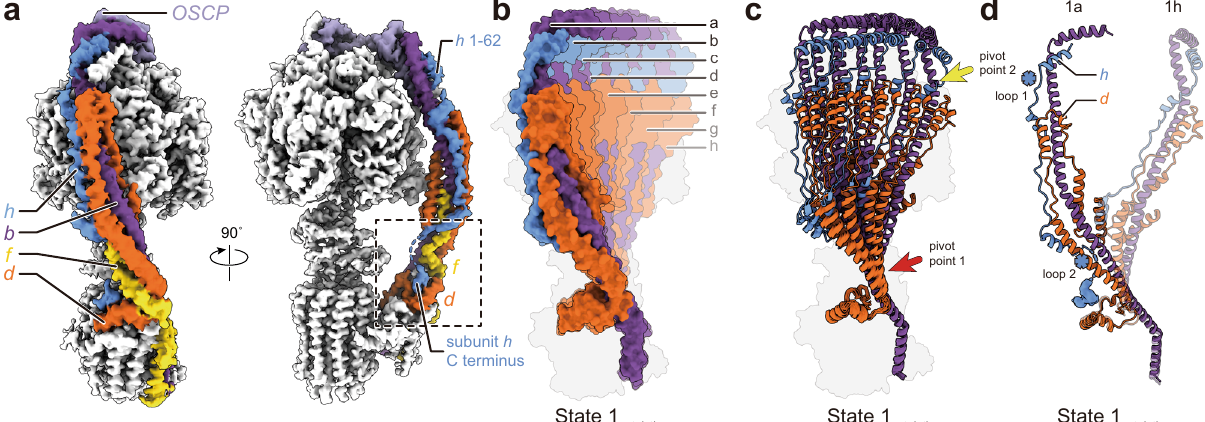
Fig. 3 Deformation of the peripheral stalk of ATP synthase while under strain during ATP hydrolysis. a Structure of the peripheral stalk shows that subunit h bridges F 1 and F O . b Overlay of the eight State 1 catalytic atomic models, produced by molecular dynamics fl exible fi tting of the atomic model of resting ATP synthase into the eight 3D maps of State 1 catalytic , shows a large deformation of the peripheral stalk. c The peripheral stalk bends at two pivot points near F 1 (yellow arrow) and near F O (red arrow). d Unstructured regions in subunit h (blue asterisks) allow it to withstand the bending of subunit